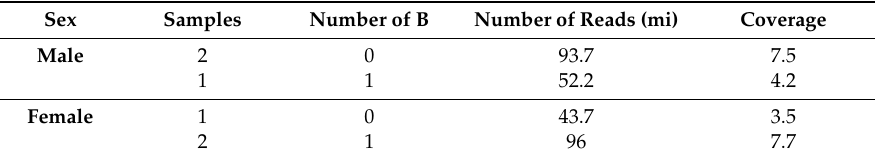
Table 3. Genome coverage and samples of Illumina